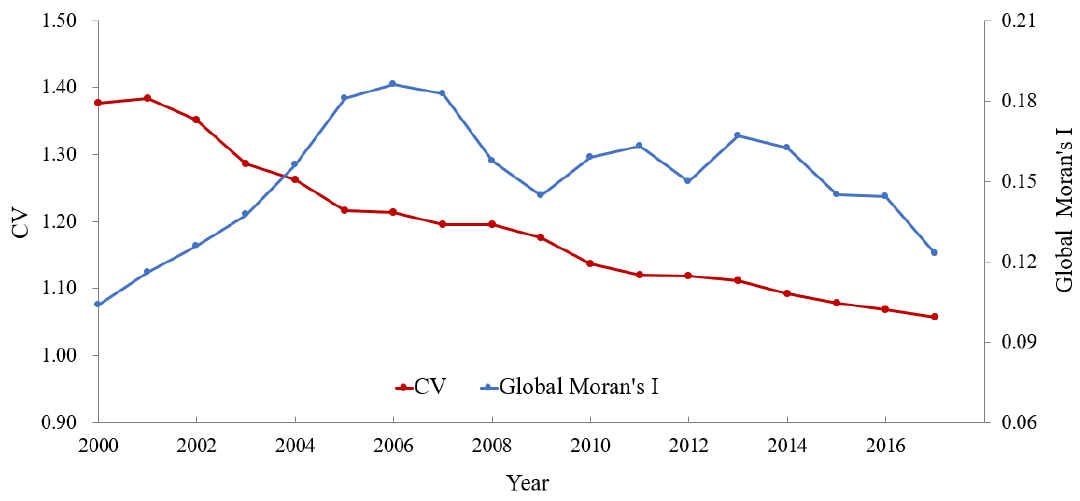
Figure 6. CV and Global Moran’s I of carbon emissions at the city level for the periods 2000–2017.